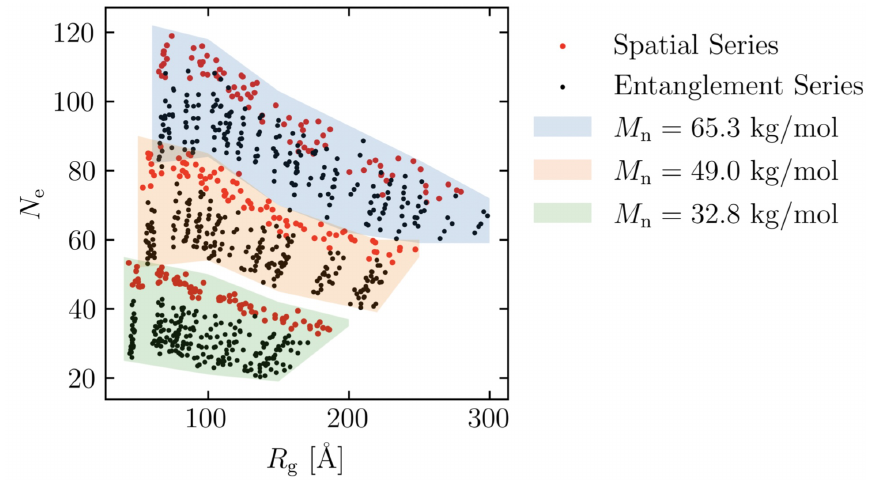
Figure 4. Distribution of radius of gyration and number of entanglement for all molecular structures. Spatial series and entanglement series are denoted as red and black dots, respectively. Each shaded background represents different molecular weight ( M n ): (green) 32.8 kg/mol, (orange) 49.0 kg/mol and (blue) 65.3